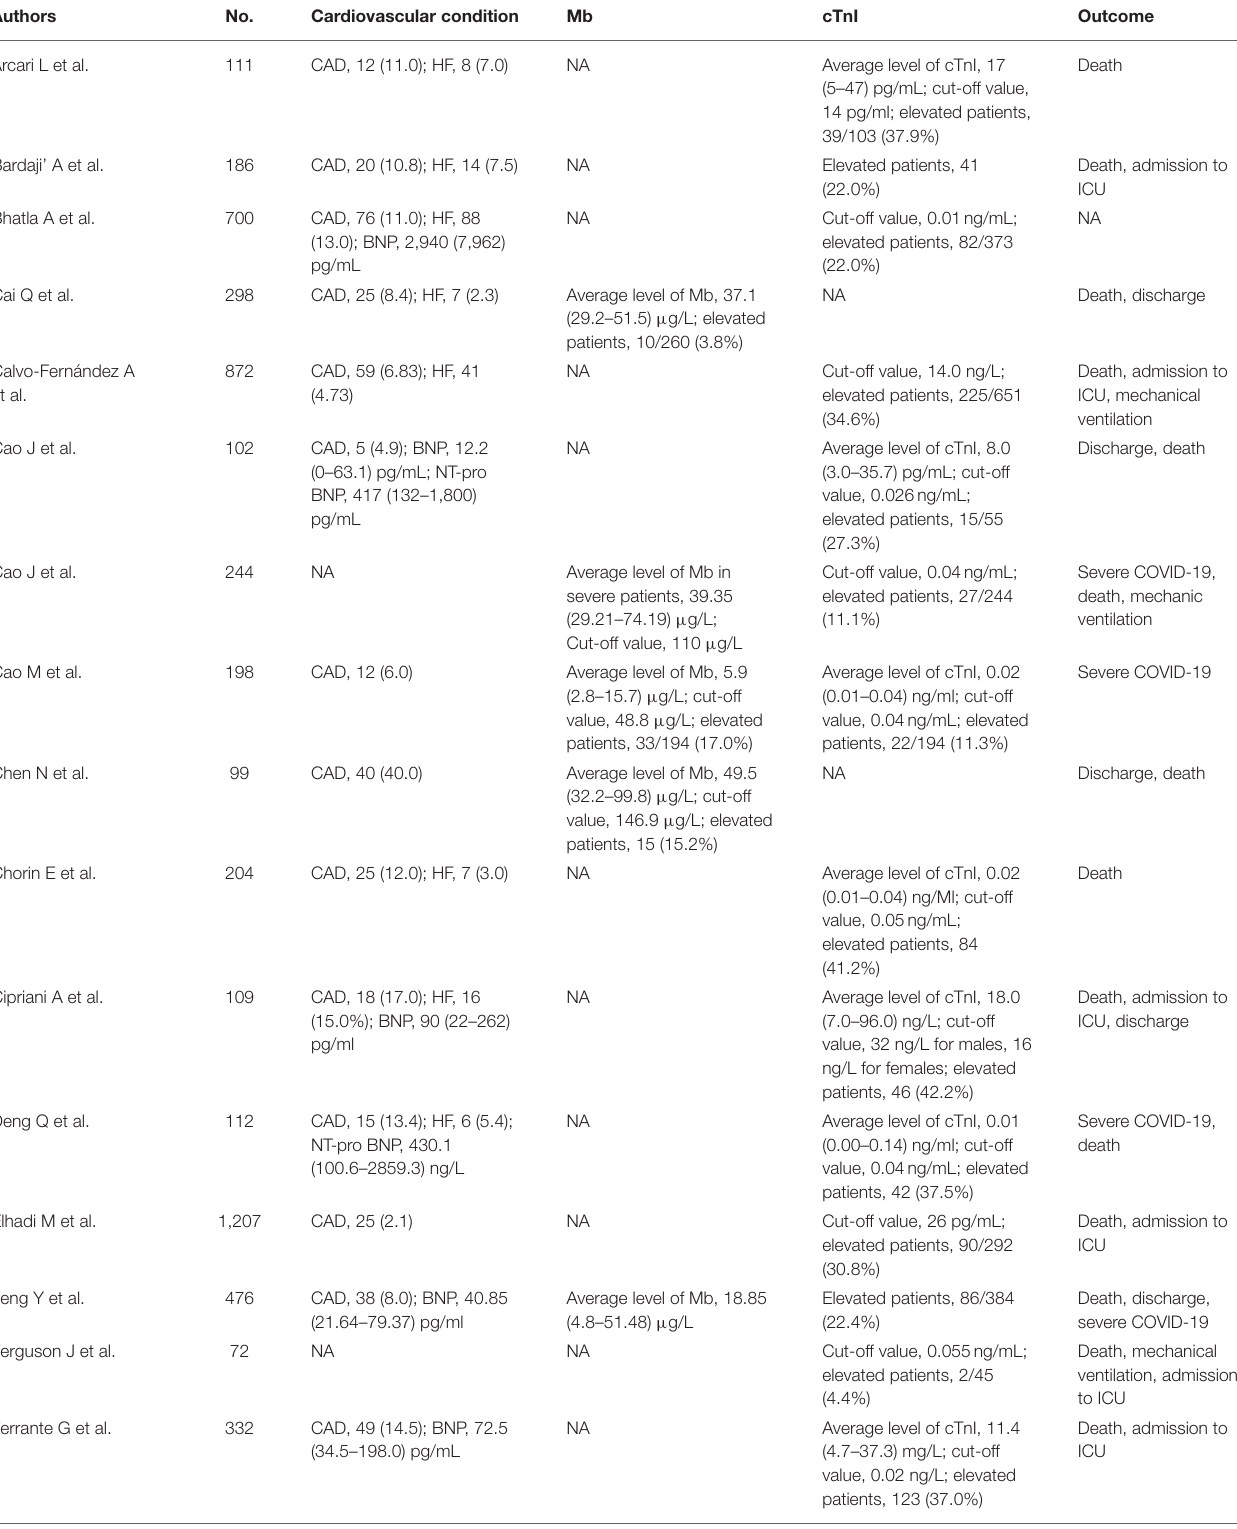
TABLE 1 | Characteristics of the included